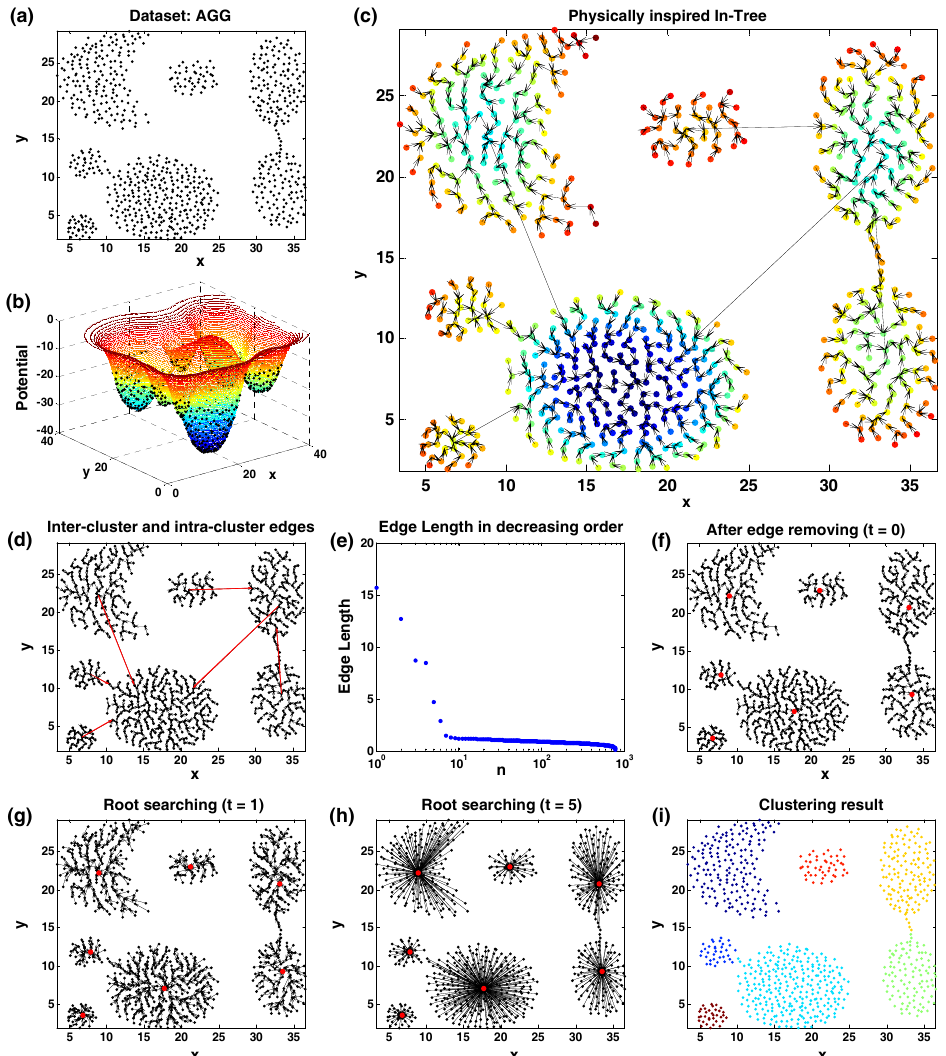
Figure 1. The idea of the proposed clustering method. ( a ) A synthetic dataset from literature [39]. ( b ) An illustration for the potential surface. As the isopotential lines vary from red to blue, the potentials in the corresponding areas become lower and lower. ( c ) The constructed In-Tree . The colors on nodes denote the potentials corresponding to the cases in ( b ). ( d ) The constructed in-tree, in which the inter-cluster edges are colored in red while the intra-cluster edges are in black. Note that the graph structures in ( c , d ) are the same. ( e ) The plot in which the lengths of all the edges in the In-Tree are arranged in decreasing order. ( f ) The result after removing the undesired edges (i.e., the inter-cluster edges). The nodes in red are the root nodes of sub-graphs. ( g ) The result after the first round of parallel searching of the root node for each non-root node. ( h ) The results after the last round of parallel searching of the root nodes. All the non-root nodes are directly linked to their root nodes. ( i ) The clustering result. The samples in the same colors are assigned to the same